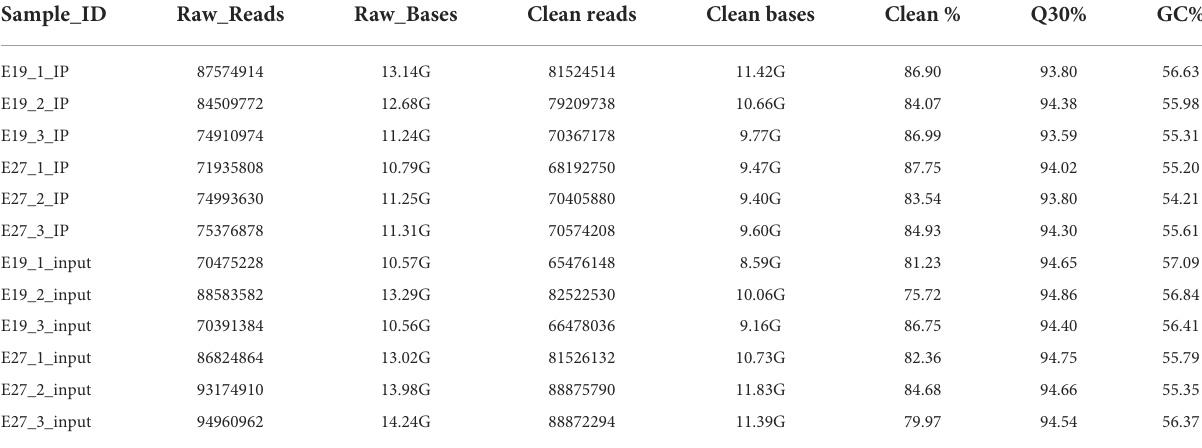
TABLE 2 Descriptive statistics of sequenced data.